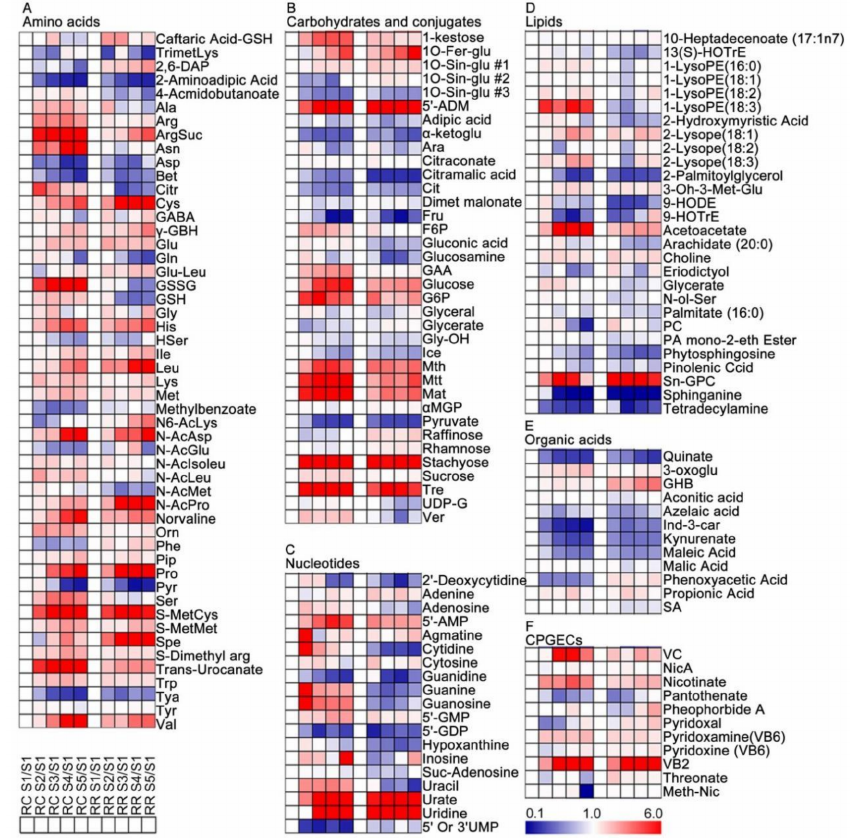
Figure 2. Heatmap of the primary metabolite changes in pulp tissues of developing berries for each cultivation method as compared with S1 stage. ( A ) Amino acids and derivatives; ( B ) carbohydrates and conjugates; ( C ) nucleotides; ( D ) lipids; ( E ) organic acids; ( F ) CPGECs. RR and RC are the abbreviations of root restriction and traditional cultivation, respectively. A t -test was performed for statistical analysis. Each data was the mean value of three biological replicates. The full names of metabolites are attached to Supplementary Table